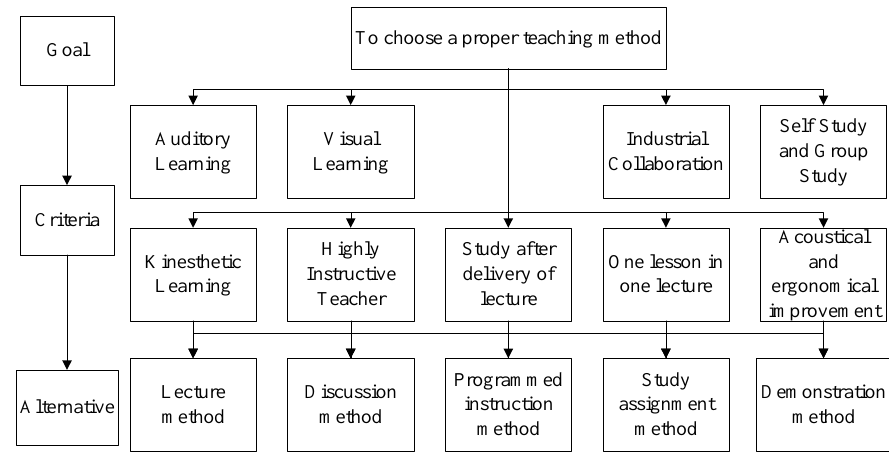
Figure. 2. Framework. Table 1. Linguistic terms for alternative ratings.